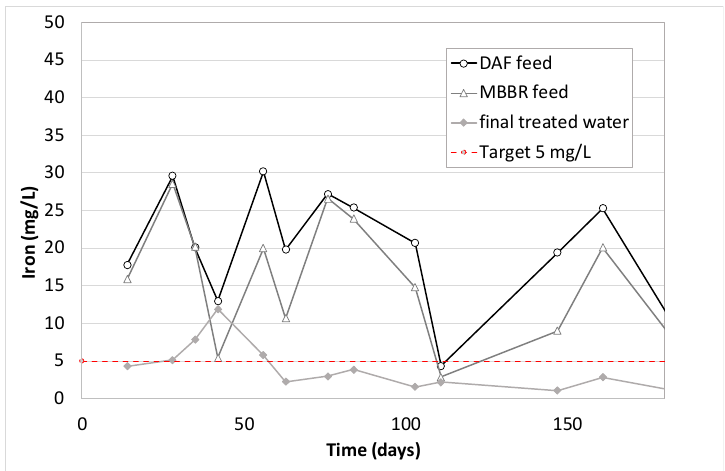
Figure 17. Lead concentration along the pilot unit versus time of operation.